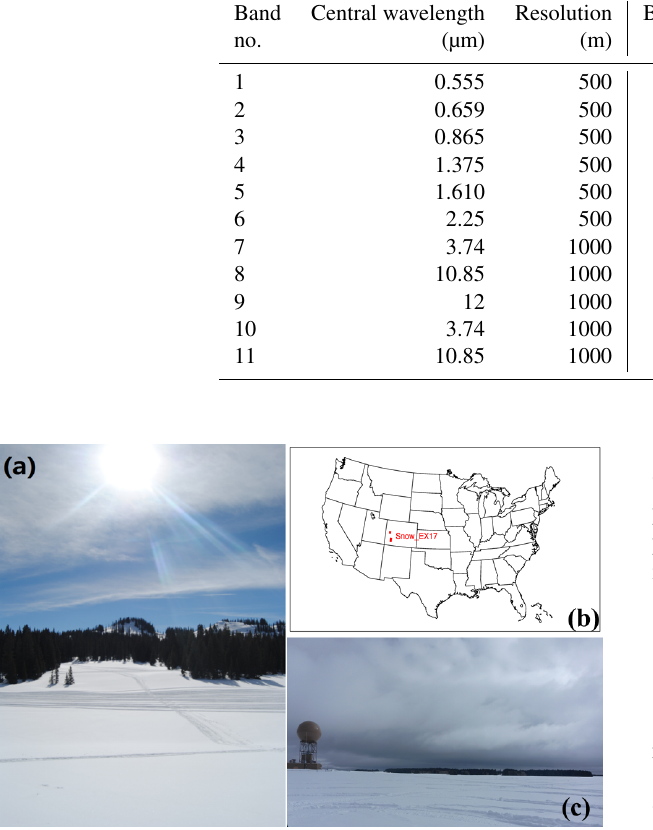
Figure 2. Photos taken during the SnowEx campaign. (a) An overview of the campaign environment around the Senator Beck Basin site. (b) Location of the SnowEx campaign (red rectangles). (c) An overview of the campaign environment around the Grand Mesa site. (Credit: Roy A. Langlois and Lisa Brucker at the